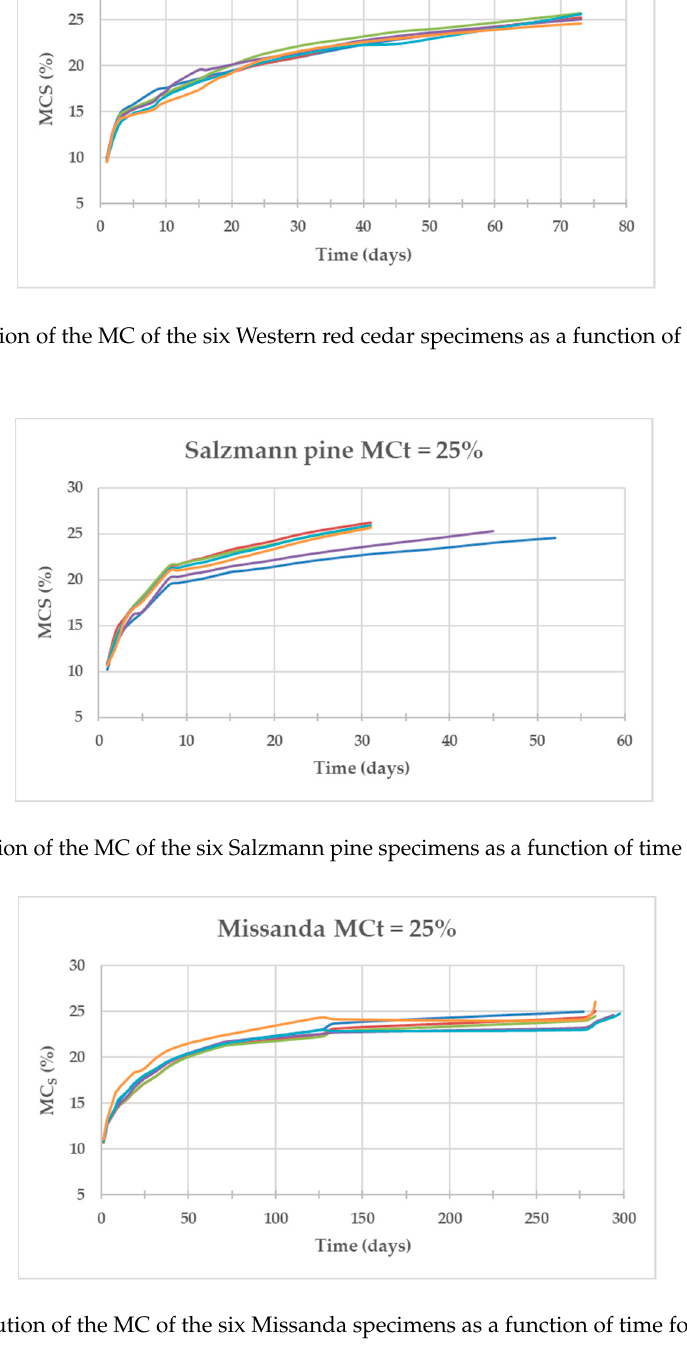
Figure 6. Evolution of the MC of the six Missanda specimens as a function of time for MCt = 25%.